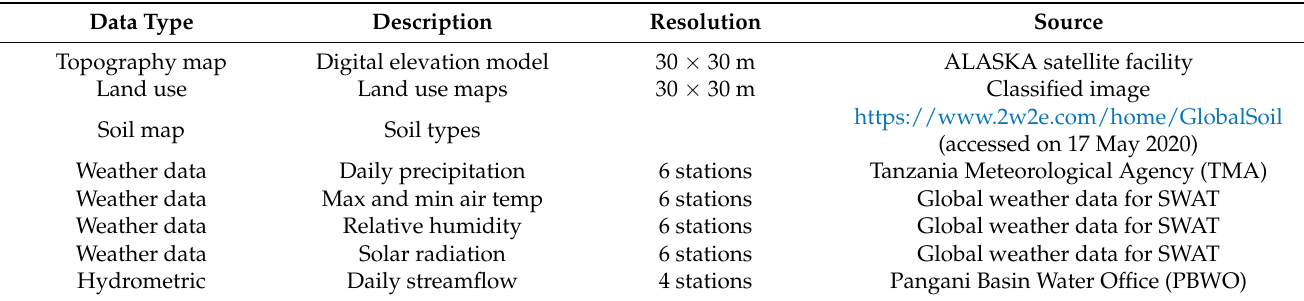
Table 1. Description of data types and